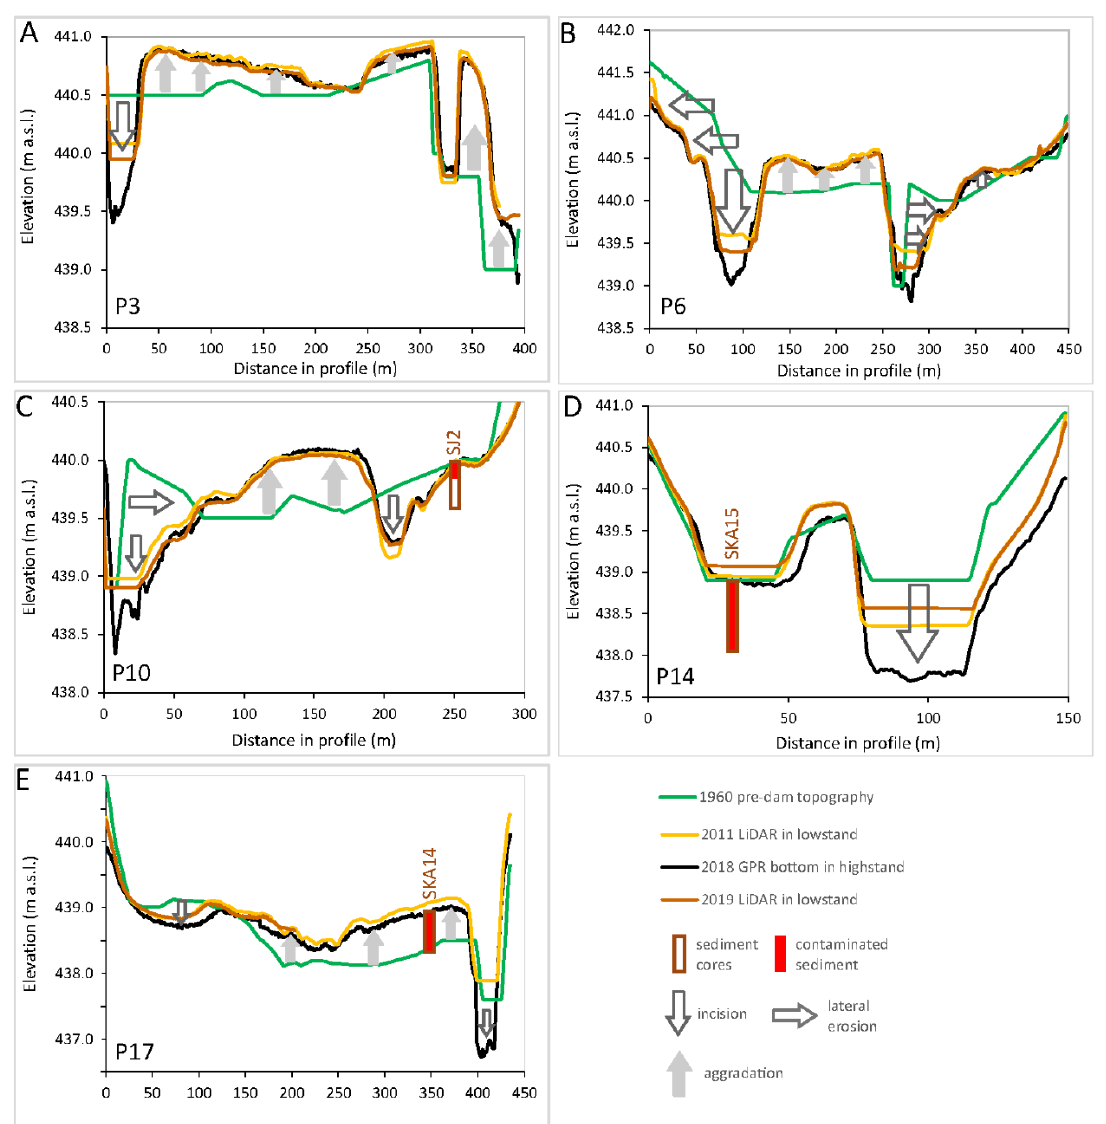
Figure 6. Elevation changes in selected transect profiles in the Skalka inflow showing changes within each profile. ( A ) Profile P3, ( B ) profile P6, ( C ) profile P10, ( D ) profile P14, ( E ) profile P17.